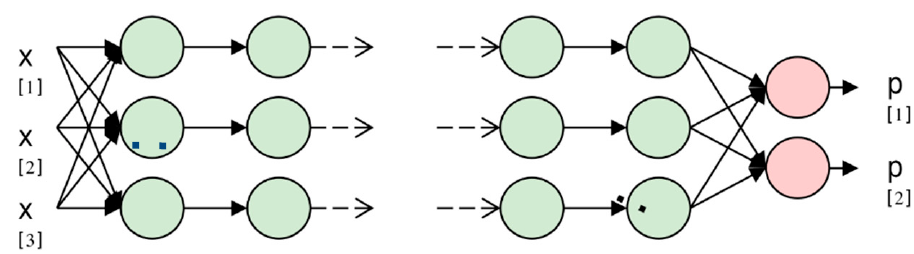
Figure 3. DSC operation diagram.